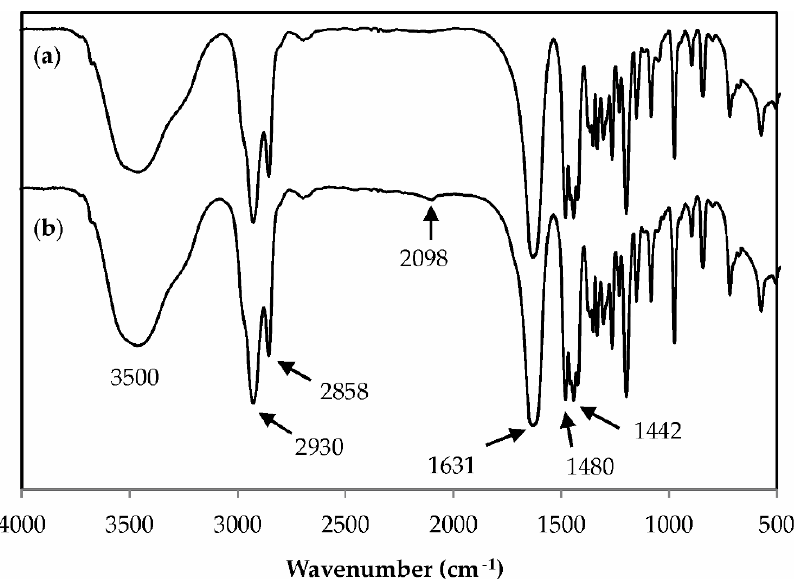
Figure 2. Fourier-Transform Infrared ( FTIR) spectra of PNVCL–OH before ( a , X-PNVCL–OH) and after ( b, PNVCL–OH) reaction with AIBN.